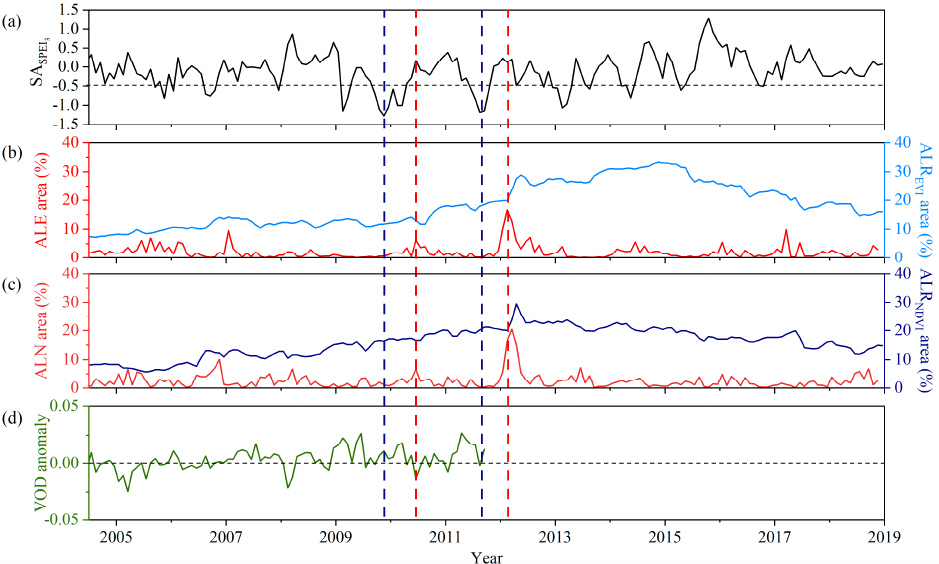
Figure 4. Temporal series of drought severity, the areas of ALE and ALR EVI , the area of ALN and ALR NDVI , and VOD anomaly. ( a ) The monthly standardized anomaly of SPEI 3 for the Southwest China; ( b ) proportion of the area showing ALE (red) and ALR EVI (blue); ( c ) proportion of the area showing ALN (dark red) and ALR NDVI (dark blue); ( d ) the monthly VOD anomaly for Southwest China. The blue vertical dotted line represents the most severe moment of the two drought events and the red vertical dotted line represents the moment of the sharp increase in ALE, ALREVI, ALN and ALRNDVI. Each tick on the x axis represents January of each year.